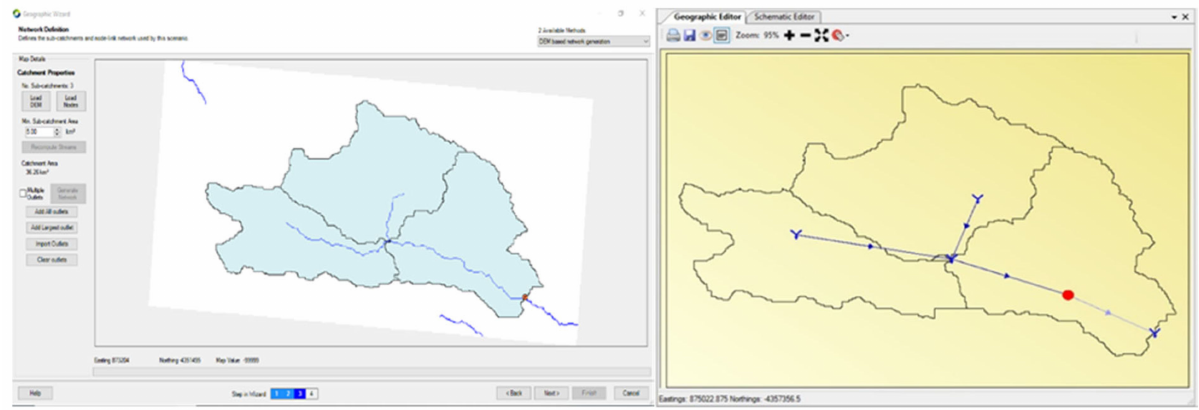
Figure 2. Depiction of the drainage lines of the Painkalac